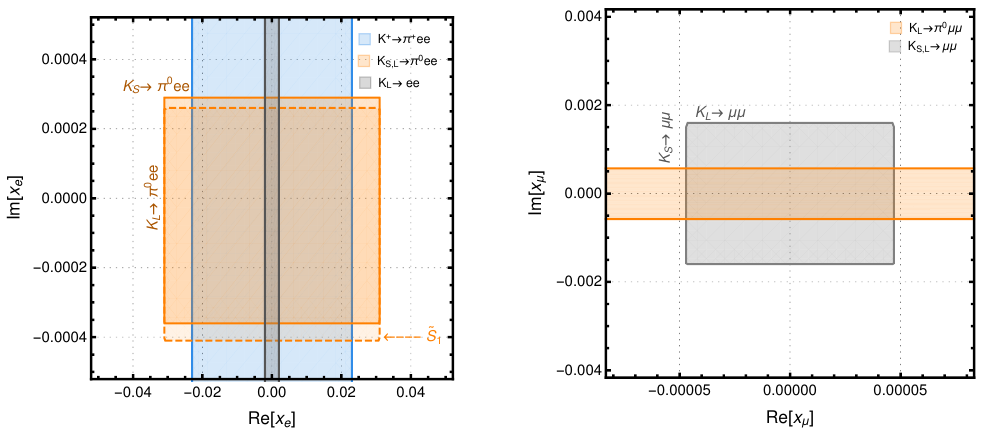
Figure 3 . Allowed regions in the plane (Re[ x ‘ ] ; Im[ x ‘ ]), arising from leptonic and rare semileptonic kaon decays, for the electron (left panel) and muon (right panel)